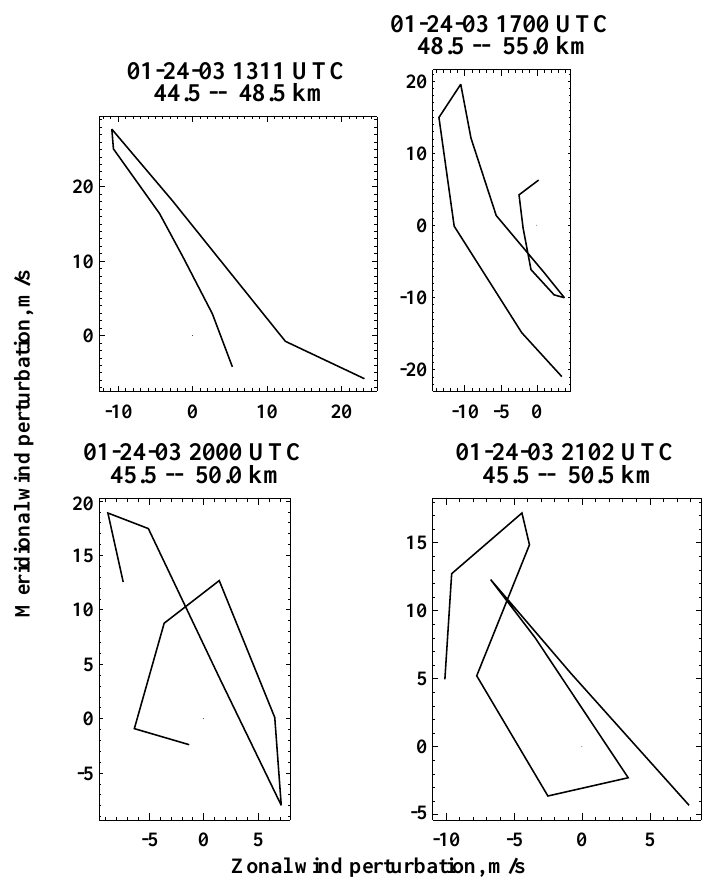
Fig. 9. Some of the gravity wave perturbation hodographs for FS Salvo 1 at around 45–50km.